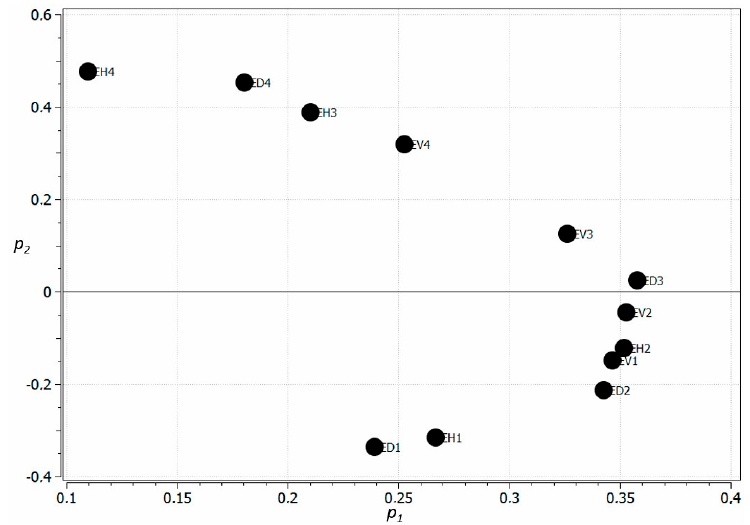
Figure 6. Loading plot of the PCA model ( p 1 – p 2 ) built on image textural features ( Y data). The